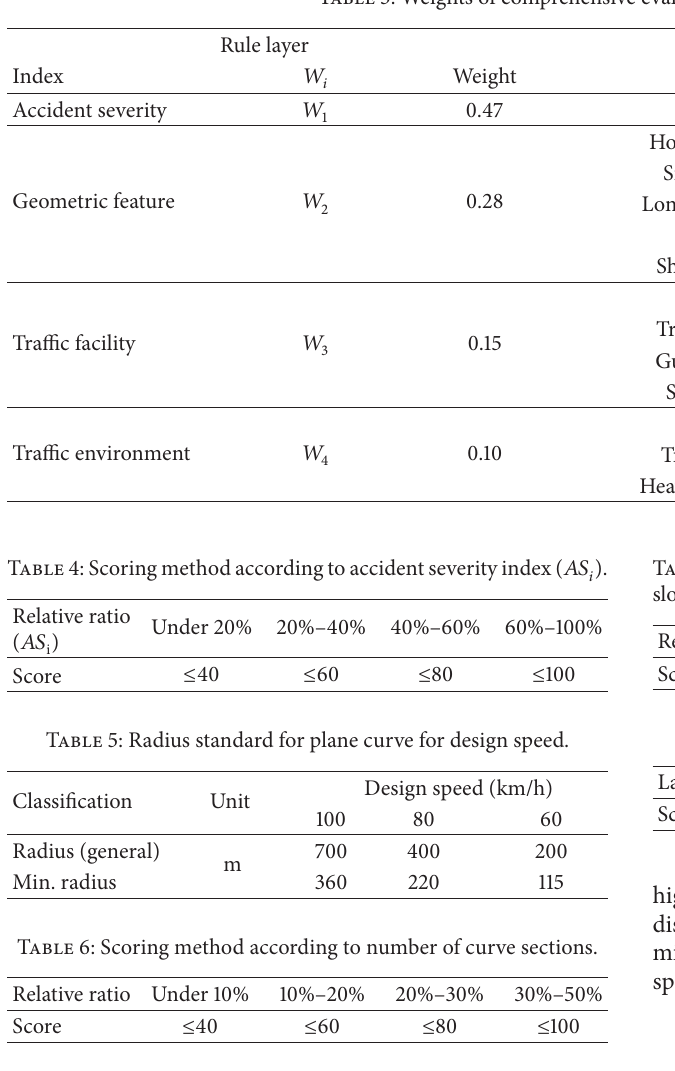
Table 3: Weights of comprehensive evaluation on provincial highway.